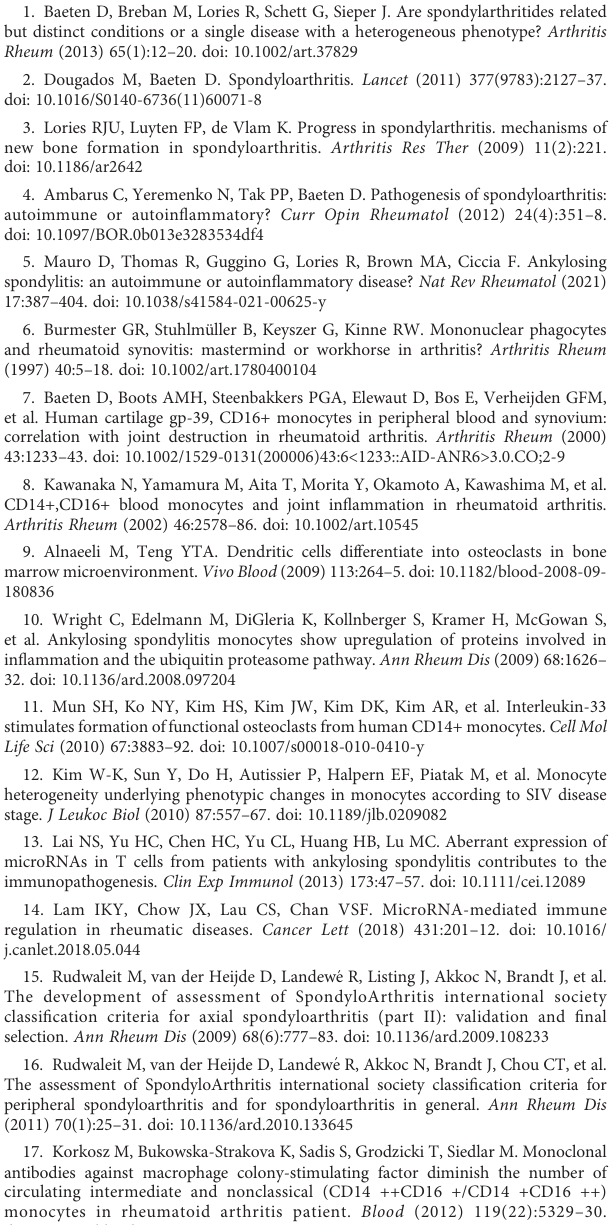
SUPPLEMENTARY FIGURE 1 FACS gating strategy for isolation of classical, intermediate and non-classical monocyte subsets. P1 – gate containing monocytes and NK cells; P2 – gate containing monocytes; P3,P4, P5 – gates containing non-classical, intermediate and classical monocytes respectively. SUPPLEMENTARY FIGURE 2 OpenArray MicroRNAExpressionWork fl owpresentingmethodological aspects of miRNA expression analysis in human monocyte subpopulations.